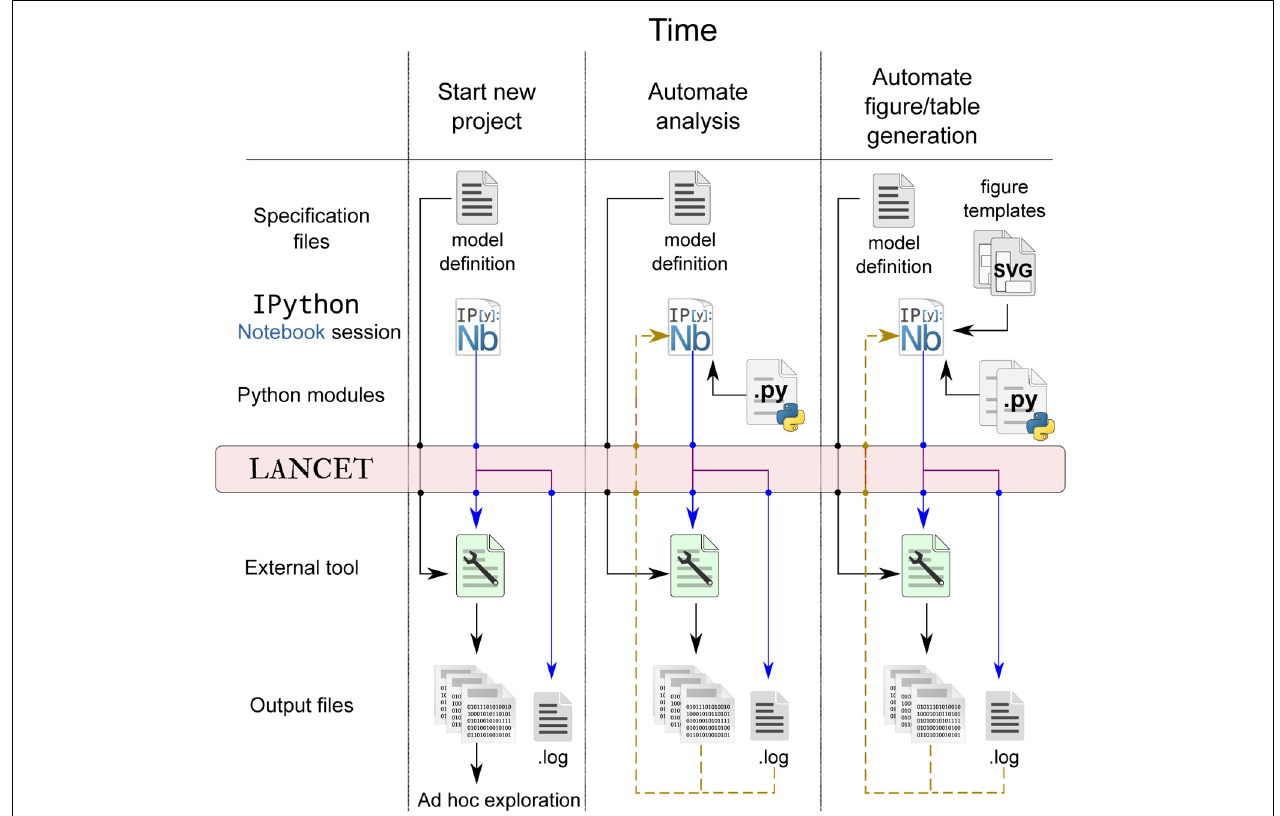
FIGURE 4 | Lancet captures a full declarative specification of the parameters, tools and platform employed, each time data is generated at every stage of the workflow. Early in the project, the output files may be rapidly explored in an ad hoc way that does not need to be automated or reproducible, as illustrated in the first